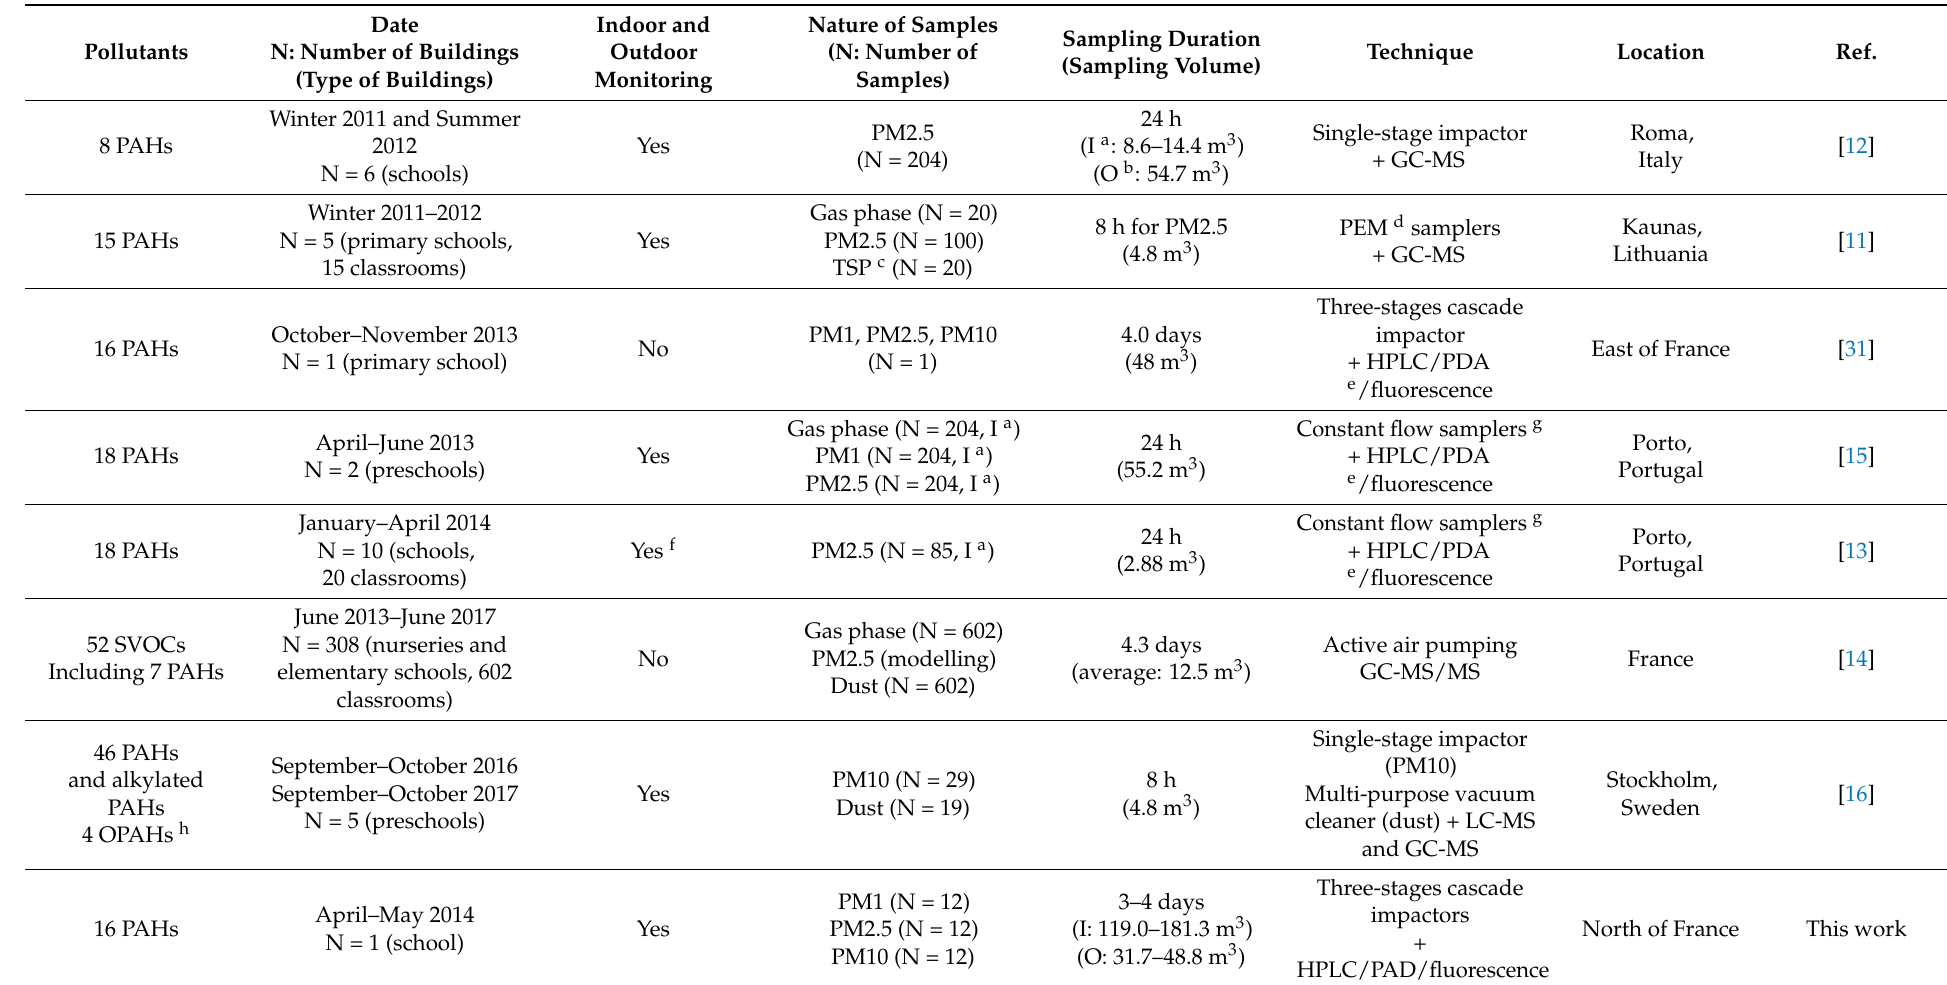
Table 1. List of previous studies dedicated to PAHs measurements in European